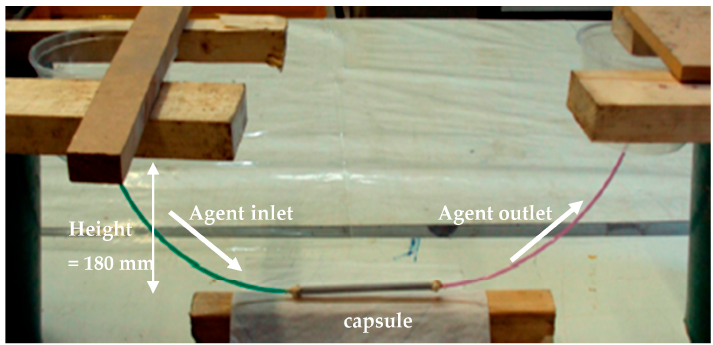
Figure 16. Testing the flow of PU-based healing agent in one tube.